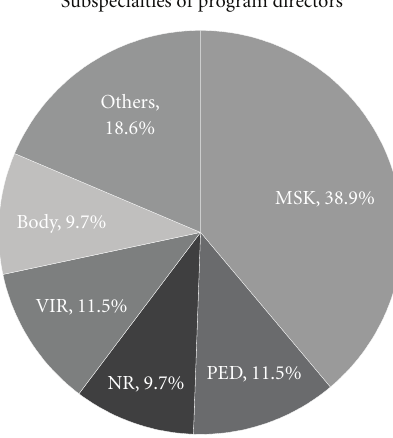
Figure 1: Pie chart showing the subspecialty distribution of program